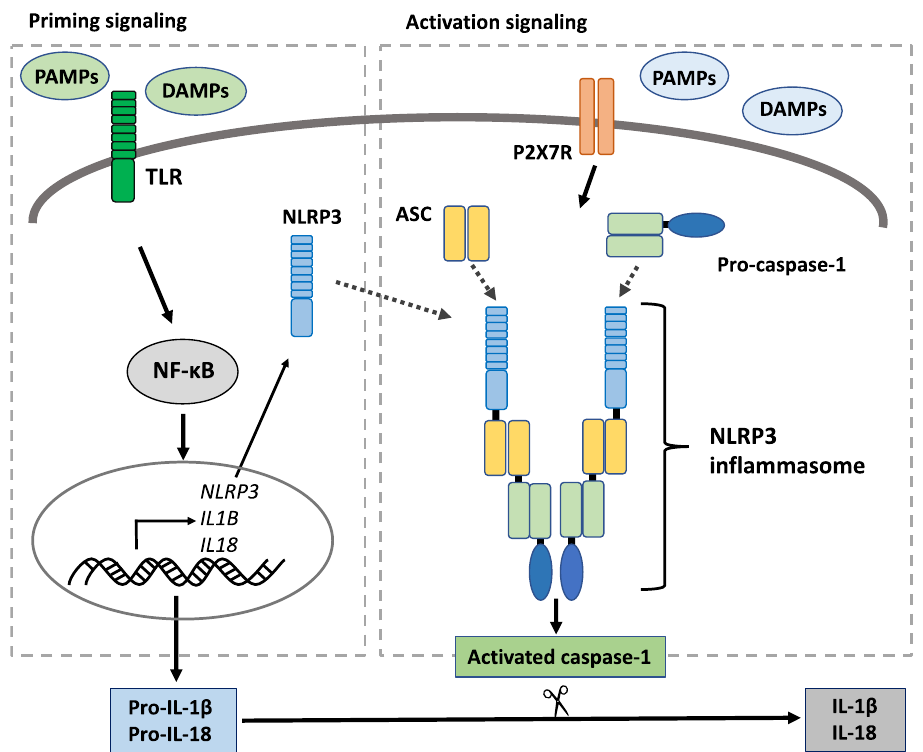
Figure 3. Mechanism of the NLRP3 inflammasome pathway. NLRP3 inflammasomes are formed by priming and activation signaling. In the priming signaling, several pathogen-associated molecular patterns (PAMPs) or danger-associated molecular patterns (DAMPs) bind to the pattern-recognition receptors (PRRs) such as Toll-like receptors and activate the NF- κ B signaling pathway, which leads to the upregulation of NLRP3, pro-interleukin (IL)-1 β , and pro-IL-18. In the activation signaling, various PAMPs, DAMPs, or intracellular changes induce the formation of the NLRP3 inflammasome composed of NLRP3 as a PRR, pro-caspase-1, and adapter proteins such as the apoptosis-associated speck-like protein containing a caspase recruitment domain that connects NLRP3 and pro-caspase-1. Then, the inflammasome complex activates pro-caspase-1. The activated caspase-1 cleaves the pro-IL-1 β and pro-IL-18 into IL-1 β and IL-18, which are biologically active forms. Abbreviations: ASC: apoptosis-associated speck-like protein containing a caspase recruitment domain; DAMP: danger-associated molecular pattern; IL: interleukin; NF- κ B: nuclear factor kappa B; NLRP3: